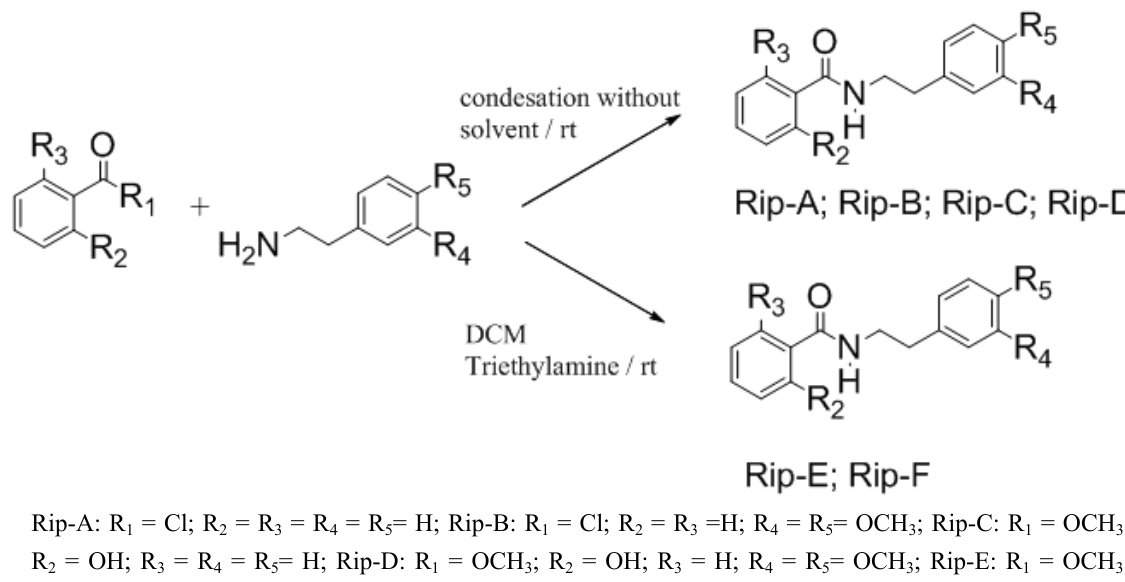
Scheme 1. General reaction of synthetic riparins A, B, C, D, E and